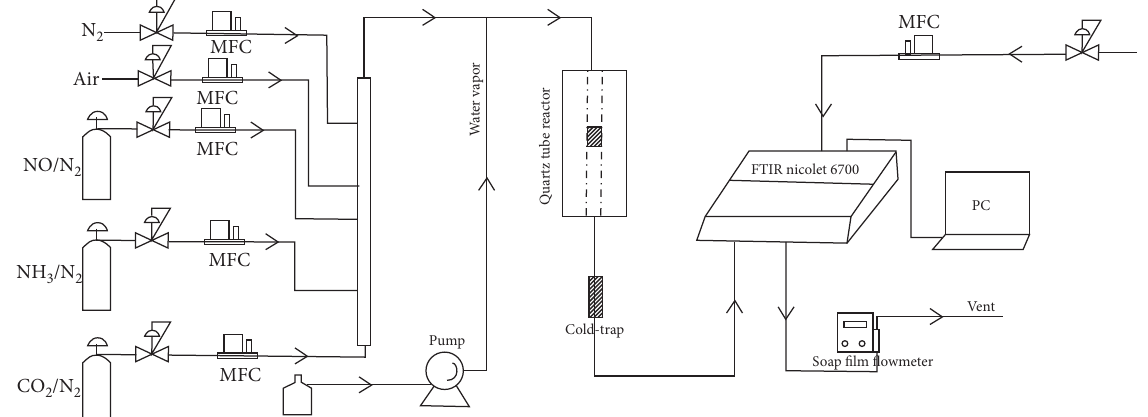
Figure 1: Activity evaluation simulation gas test